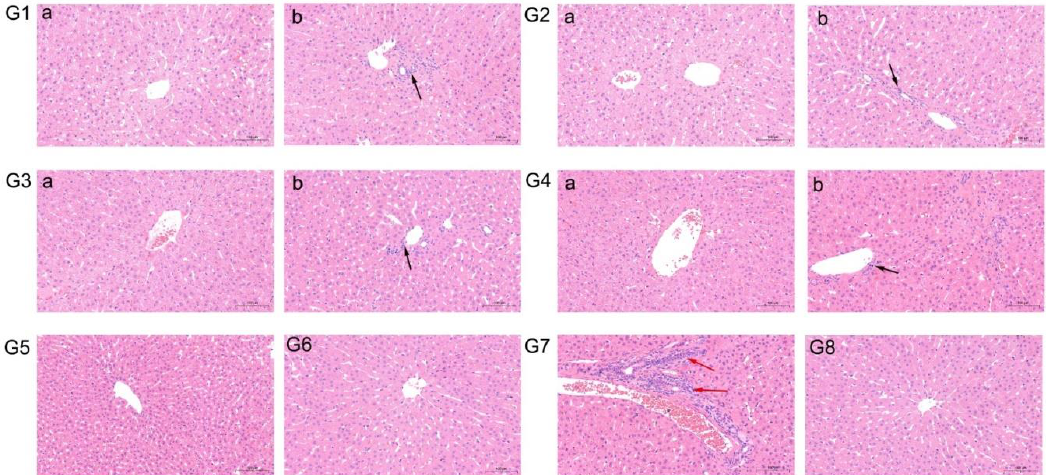
Figure 6. Various characteristics of microscopic lesions in livers from rabbits after challenged with CHN-SD-sHEV. ( G1a – G4a , G5 , G6 , G8 ) No visible pathological signs of HEV infection in liver sections (Panels ( G1a – G4a , G5 , G6 , G8 )from Rab2, Rab6, Rab11, Rab17, Rab21, Rab26, and Rab36, respectively); ( G1b )–( G4b ) Slight lymphocytic venous periphlebitis observed in liver sections (Panels ( G1b )–( G4b ) from Rab1, Rab8, Rab14, and Rab16, respectively; black arrows); ( G7 ) Severe lymphocytic venous periphlebitis in liver sections (Panel ( G7 ) from Rab31; red arrow). Tissues were stained with hematoxylin and eosin.